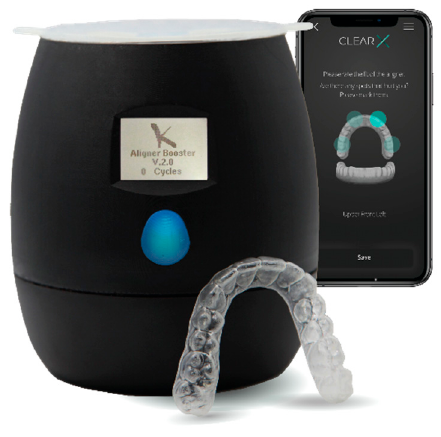
Figure 4. ClearX booster device controlled by a mobile application used for programmed activation of the ClearX aligners.